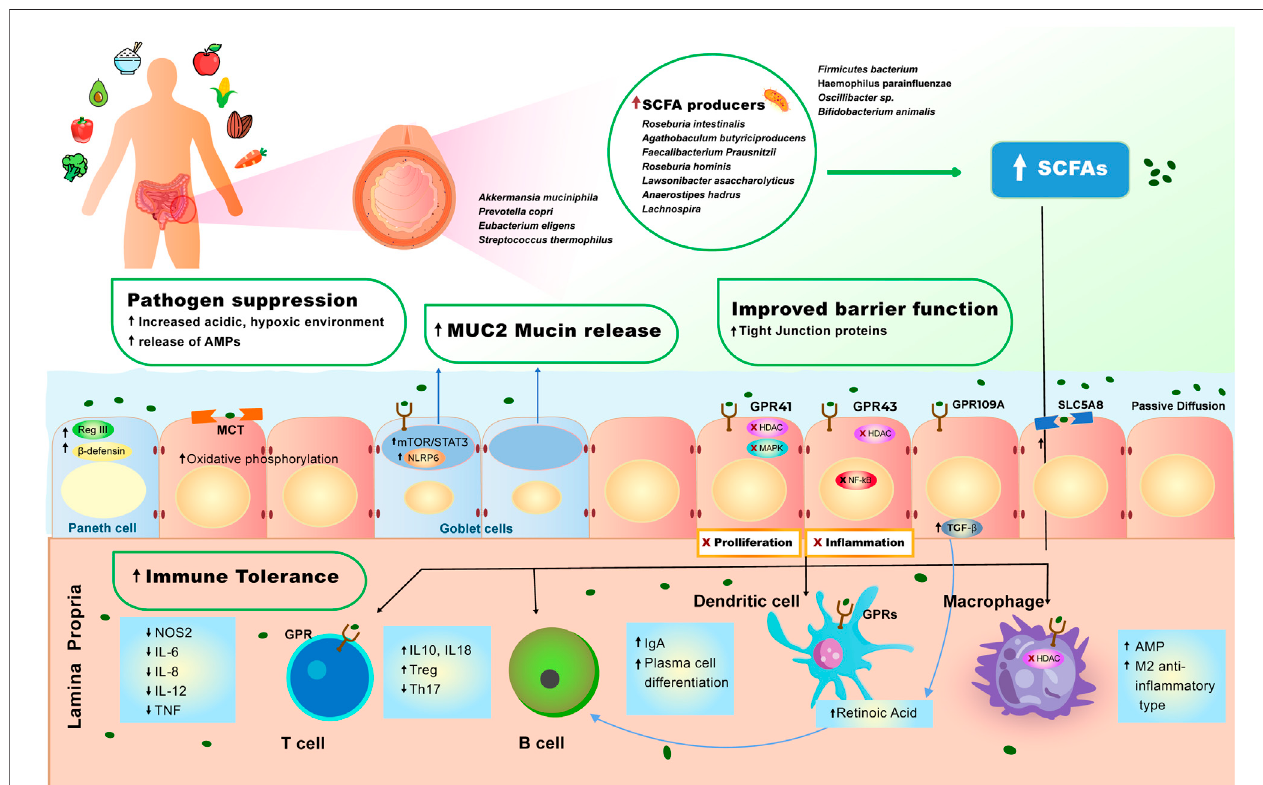
FIGURE1| Effectofplant-dietonthegutmicrobiomeandintestinalhomeostasis.Adietrichinplant-basedfoodsresultsinhighabundanceofshort-chainfattyacid (SCFA) producing bacteria in the gut lumen. High production of SCFAs by gut microbiome is strongly associated with pathogen suppression, mucus production, improved barrier function and immune tolerance (see Molecular Mechanisms of the Role of Plant-Based Diet in Cancer Protection ). SCFAs induce a set of anti- in fl ammatory events via interaction with GPR41, GPR43, GPR109A receptors and MCT and SLC5A8 transporters that are expressed on the surface of intestinal epithelial cells and immune cells. 1) SCFAs bind GPR109A on the epithelial cell which leads to increase in TGF- β production, enhancing the differentiation of Treg cells, whichleadstoincreaseofimmunetoleranceinthegut.2)SCFAsalsobindtoGPR43inhibitingHDACandNF- κ B,resultingindecreasedin fl ammation.3)SCFAsbindto GPR41,inhibitingHDACandMAPKsignalingpathway,resultingininhibitionofproliferation.4)SCFAscrosstheepithelialcellbarrierandreachlaminapropria,wherethey inducecascadeofanti-in fl ammatoryreactions,regulatingimmunehomeostasisinthelower bowel.In thelamina propria, SCFAsbindtomacrophage(MQ cell) inhibiting HDAC, facilitating polarization of macrophages to M2-anti-in fl ammatory type, and increasing production of antimicrobial peptides (AMPs). 5) SCFAs bind to dendritic (DC)cellenhancingretinoicacidproduction,furtherfacilitatingproductionimmunoglobulinA(IgA)anddifferentiationofTregs.6)SCFAsinduceproductionofTGF- β and retinoic acid, causing B cells to stimulate production of IgA and facilitate plasma B cell differentiation. 7) SCFAs bind to GPR on T cells, initiating the production of IL-10, which increases Tregs pool, and inhibits expansion of T helper (Th) 17.